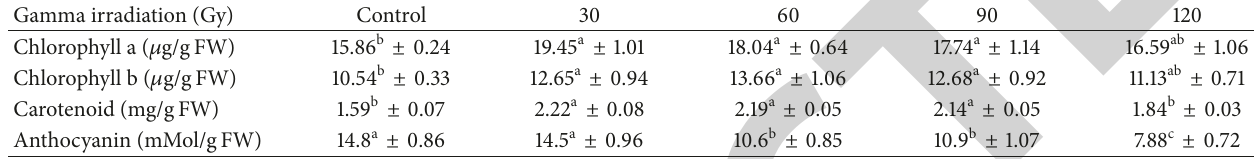
Table 2: Effect of gamma irradiation on chlorophyll, carotenoid, and anthocyanin contents of in vitro leaves. Gamma irradiation (Gy)